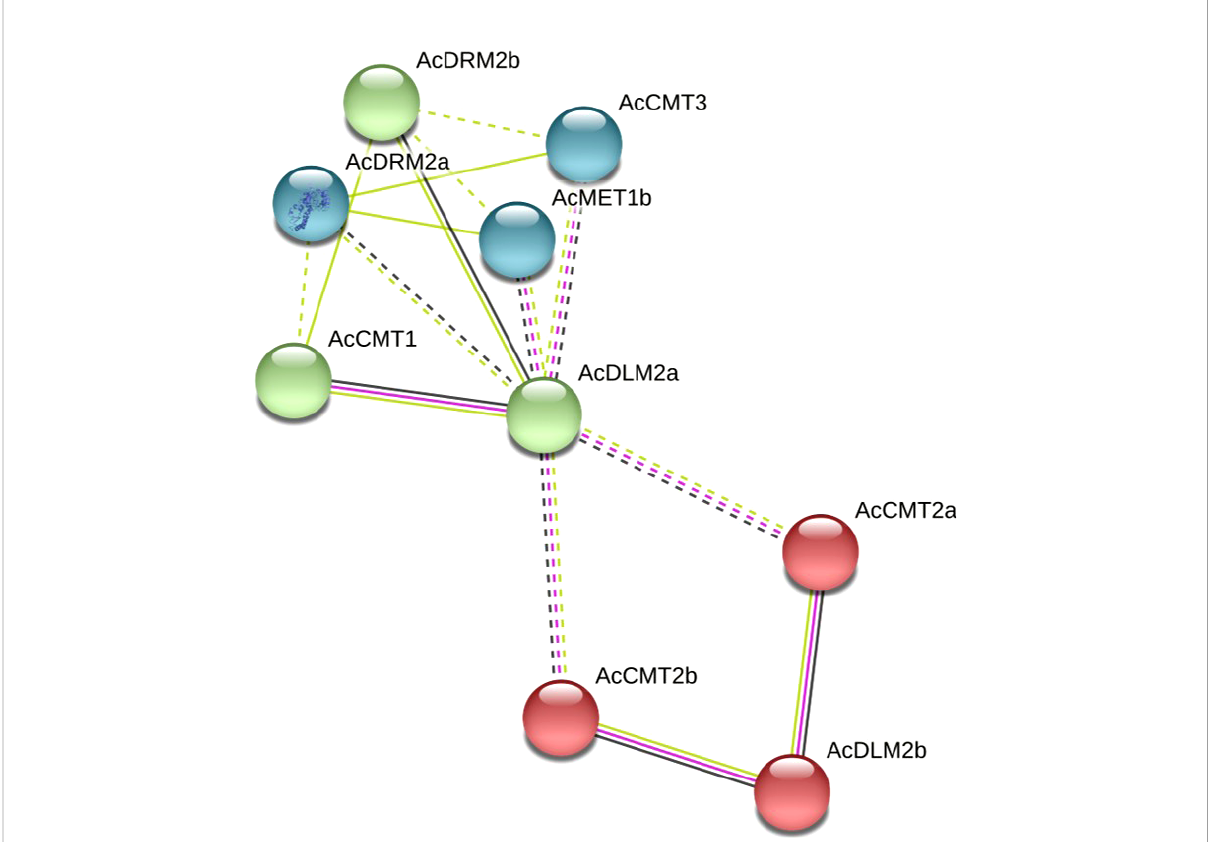
FIGURE 3 Computational prediction of protein-protein interaction network for AcC5-MTases and AcDMTases showing functional and physical associations among proteins. The dotted lines represent a relatively weak interaction while the solid lines indicate a relatively strong interaction. Colored lines between the proteins indicate the various types of interaction evidence: yellow line indicates textmining evidence, black line indicates coexpression evidence and purple line indicates experimental